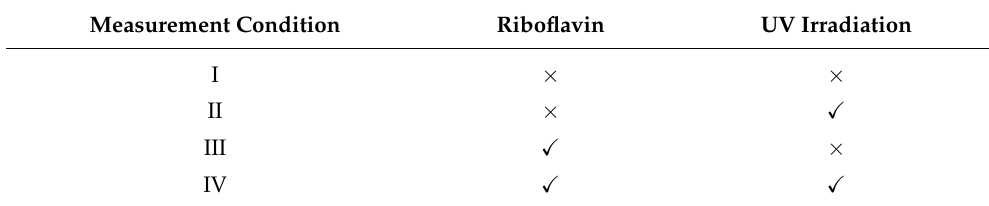
Table 2. The different measurement conditions specify the different treatments of the porcine cornea samples with UV irradiation and